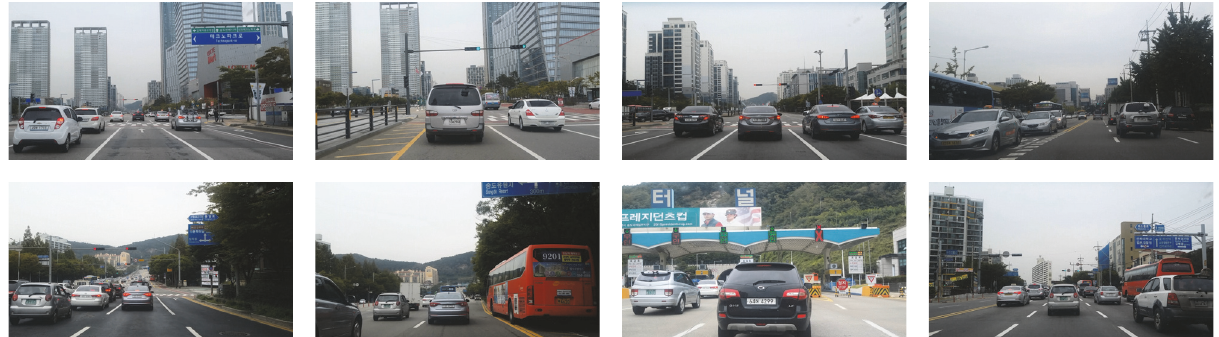
Figure 9: Examples of training and test images used for performance evaluation.